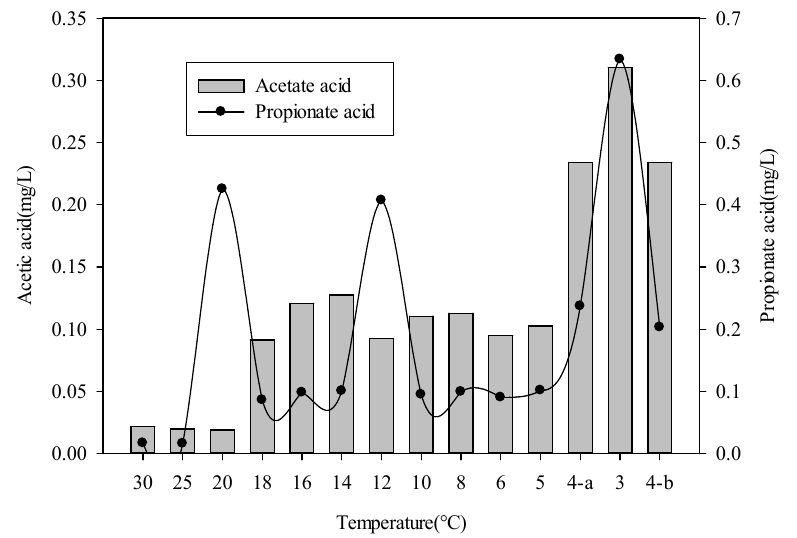
Figure 3. Temperature-dependent changes in effluent volatile fatty acids, including acetic acid and propionate acid. 4-a: Operating temperature of the reactor before the medium soured; 4-b: Recovery at 4 °C after the reactor medium soured.